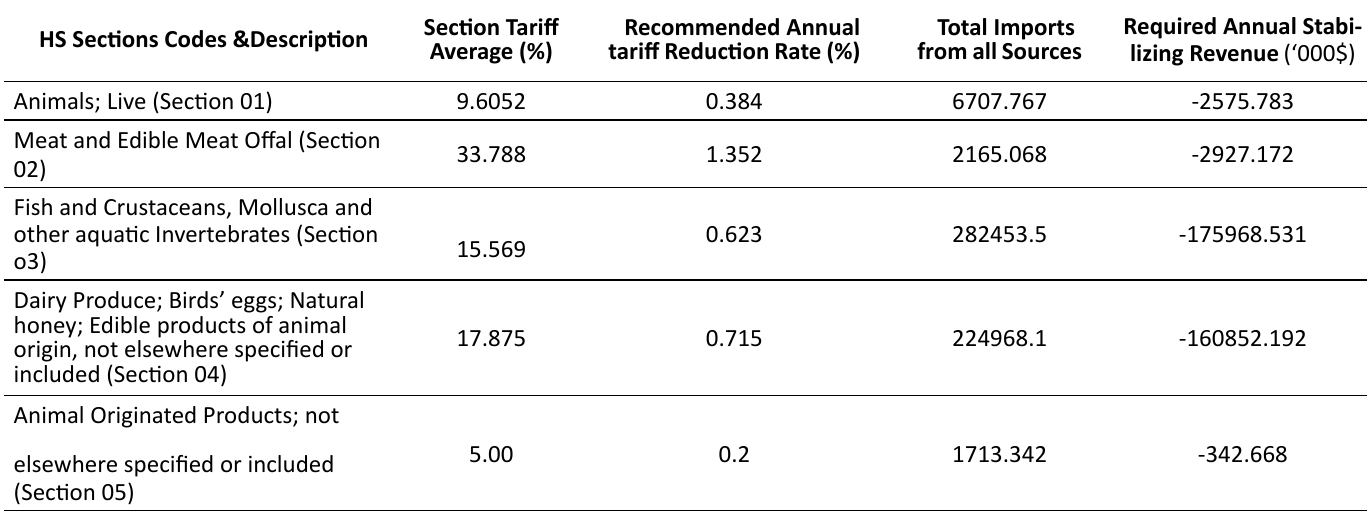
Table 3: Recommended Schedule of Tariff Reductions across Product Sections